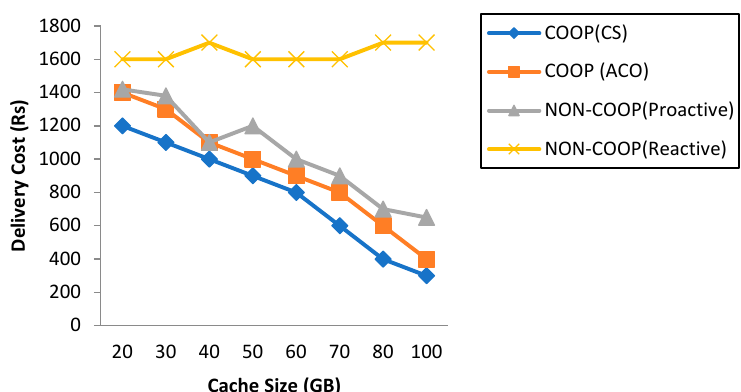
Figure 8. Delivery cost with different cache sizes.